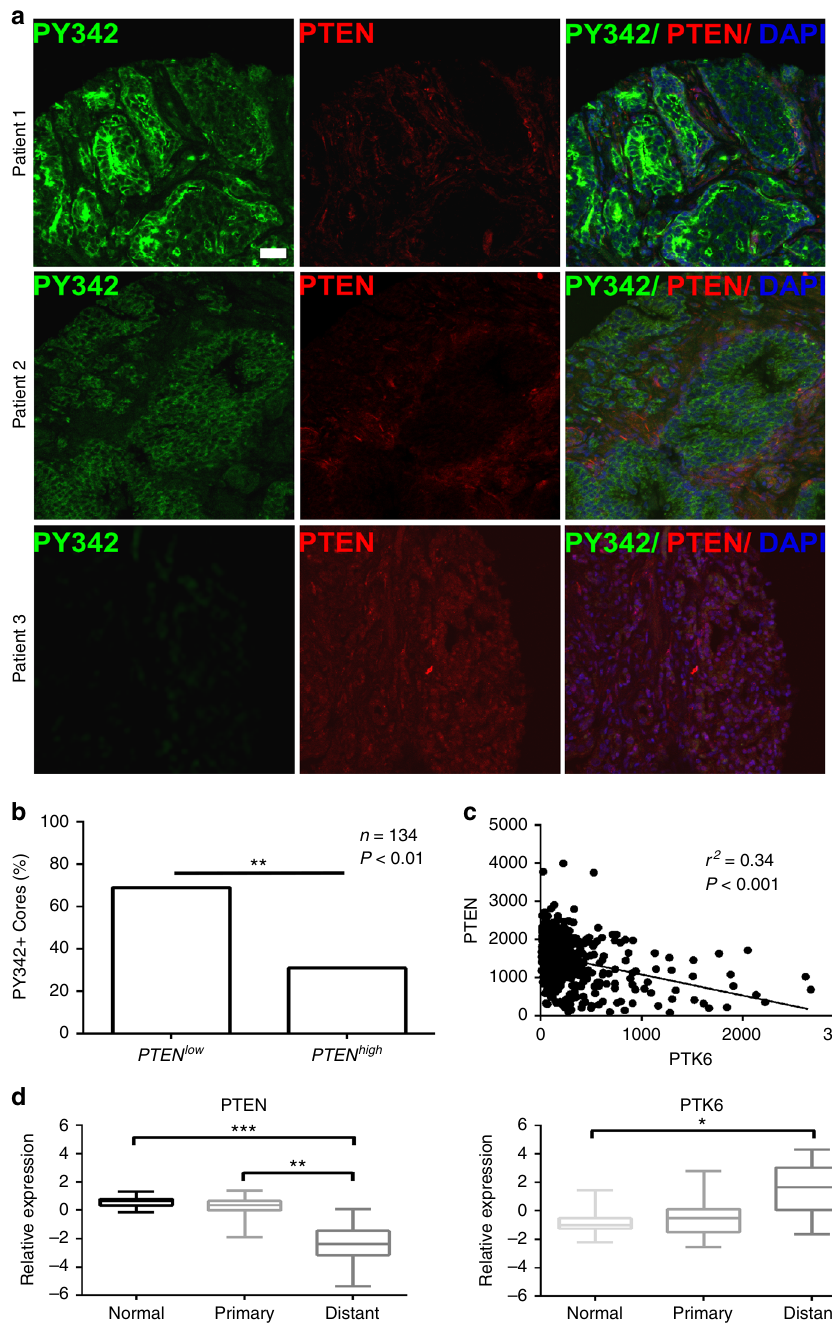
Fig. 6 PTK6 is activated in human prostate tumors that lack PTEN expression. a Immuno fl uorescence was performed on CPCTR TMA1 using antibodies speci fi c for active PTK6 (PY342, green) and total PTEN (red). Scale bar, 50 µ m. b Human prostate tumor cores displaying high level of active PTK6 were scored for PTEN expression. ( n = 131, ** P < 0.01) c Coexpression of PTEN and PTK6 mRNA from The Cancer Genome Atlas (TCGA). Linear regression analysis was performed. d PTEN and PTK6 mRNA expression data exported from the Grasso Prostate data set 49 accessed via Oncomine ( *** P < 0.001, ** P < 0.01, * P <